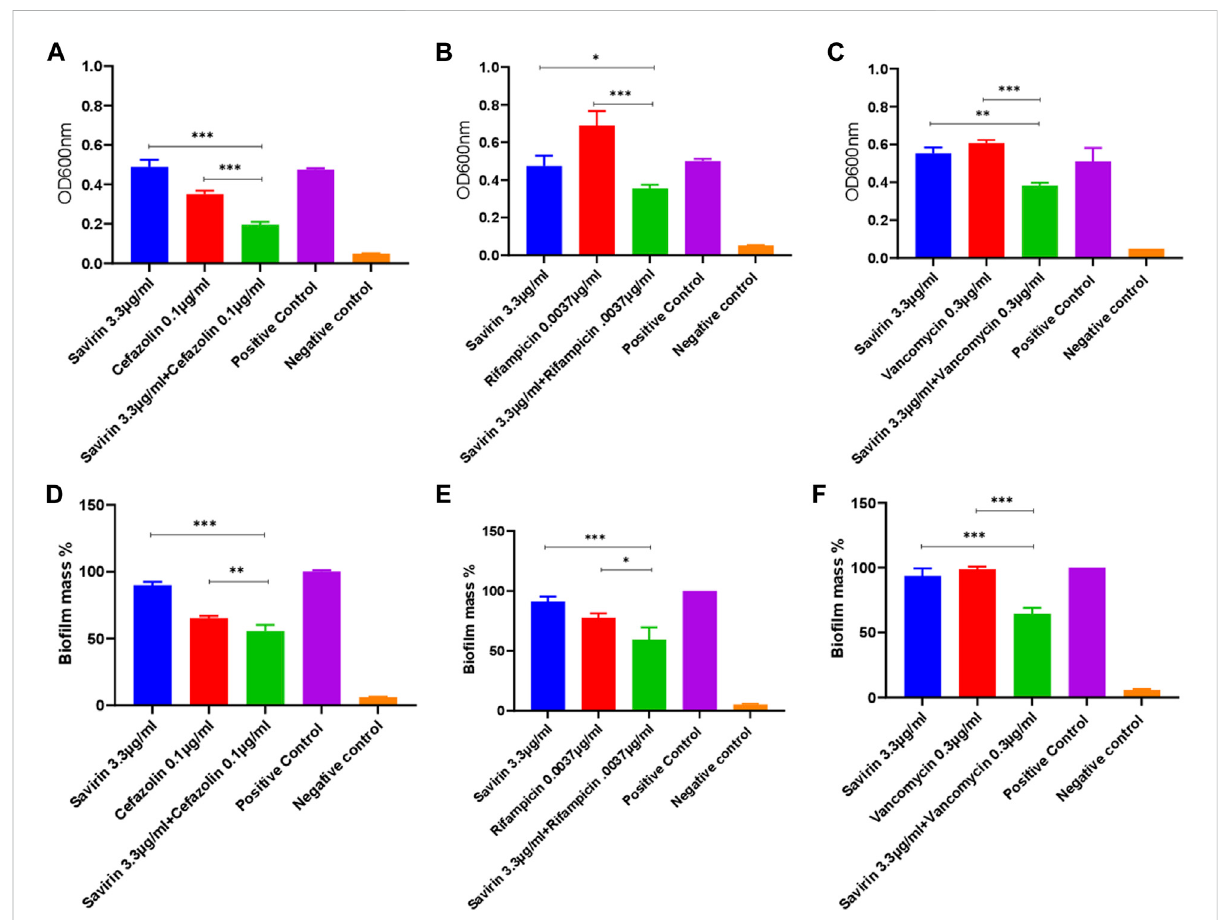
FIGURE 2 Inhibition of planktonic (A,B,C) and bio fi lm (D,E,F) growth by combined savirin and antibiotics (cefazolin, rifampicin, and vancomycin) sub- inhibitory concentrations compared with savirin and antibiotics alone (*** = p < 0.001, ** = p < 0.01, * = p < 0.05). Savirin concentration used in this experiment was sub-inhibitory. Savirin in combination with antibiotics showed enhanced antibacterial and antibio fi lm activity against S. aureus compared with savirin alone. Experiments were performed in triplicates (N = 3) and data are presented as mean ± standard deviation (SD) with error bars indicating